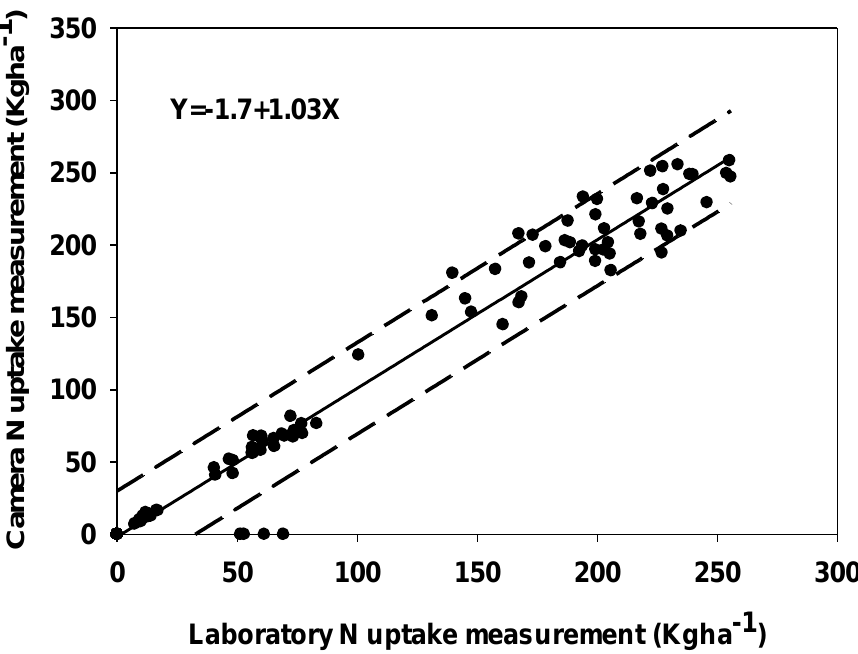
Figure 3. N uptake as determined by the camera (cam) and in the laboratory (lab) (≈90 points). The correlation includes all wheat cultivars and the three experiments. Dashed lines are the boundaries of the 95% confidence band.